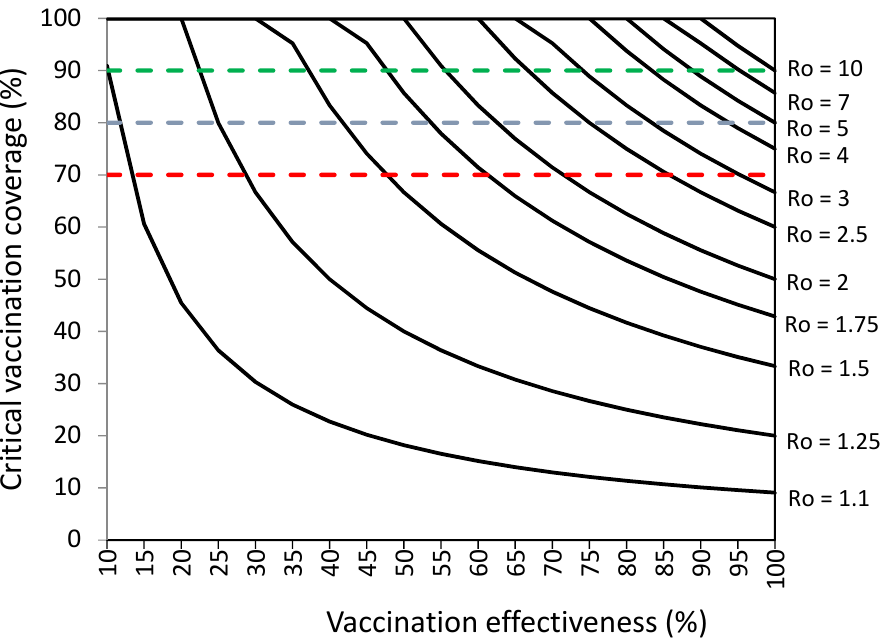
Figure 1. Vaccination coverage (%) required to establish herd immunity against SARS-CoV-2 with different reproductive numbers (Ro) by vaccination effectiveness (%). Objectives of vaccination coverage of 70%, 80%, and 90% are indicated with dashed red, blue, and green lines, respectively.